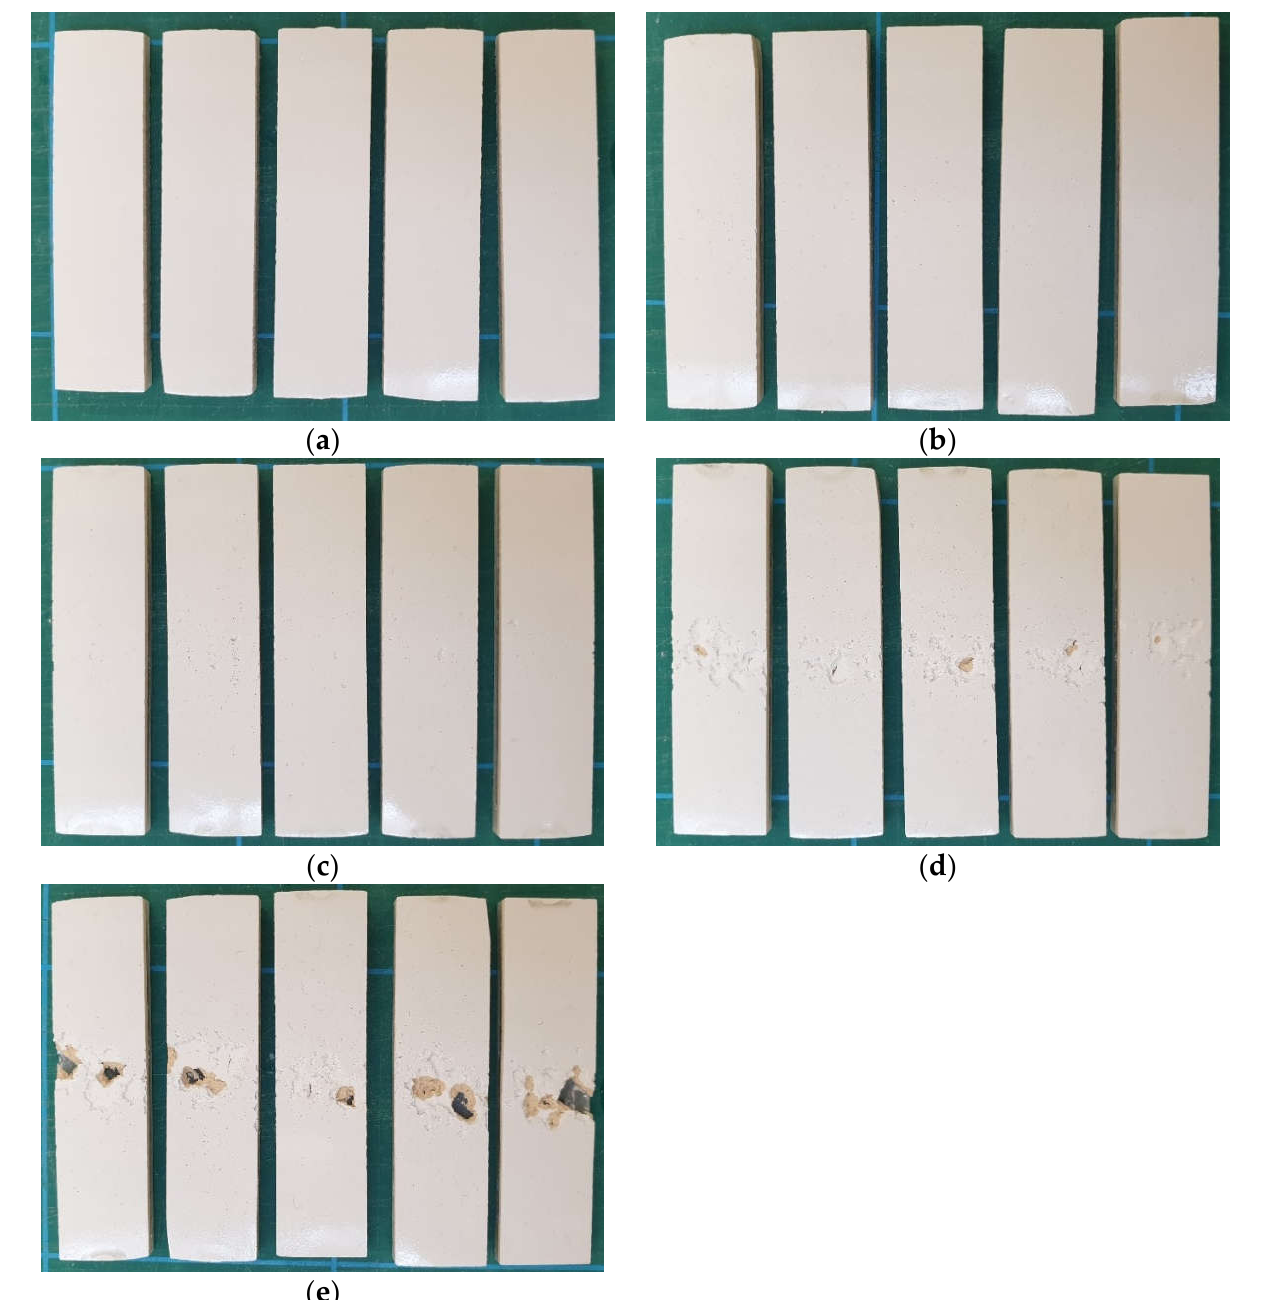
Figure 8. ( a ) Samples with coating C at stage 1; ( b ) samples with coating C at stage 2; ( c ) samples with coating C at stage 3; ( d ) samples with coating C at stage 4; ( e ) samples with coating C at stage 5.